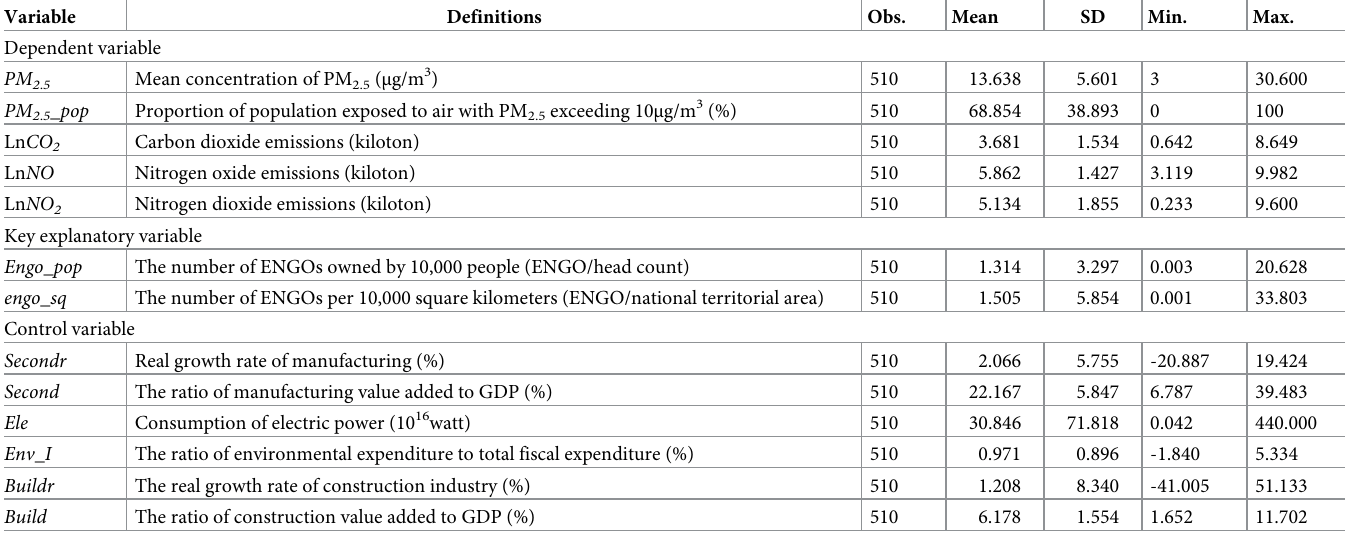
Table 1. The main variables definitions and